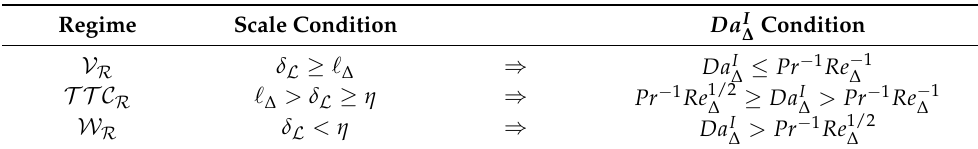
Table 2. The three main premixed combustion regimes in the LTSM framework based on the comparison between turbulent length scales and laminar flame front thickness.